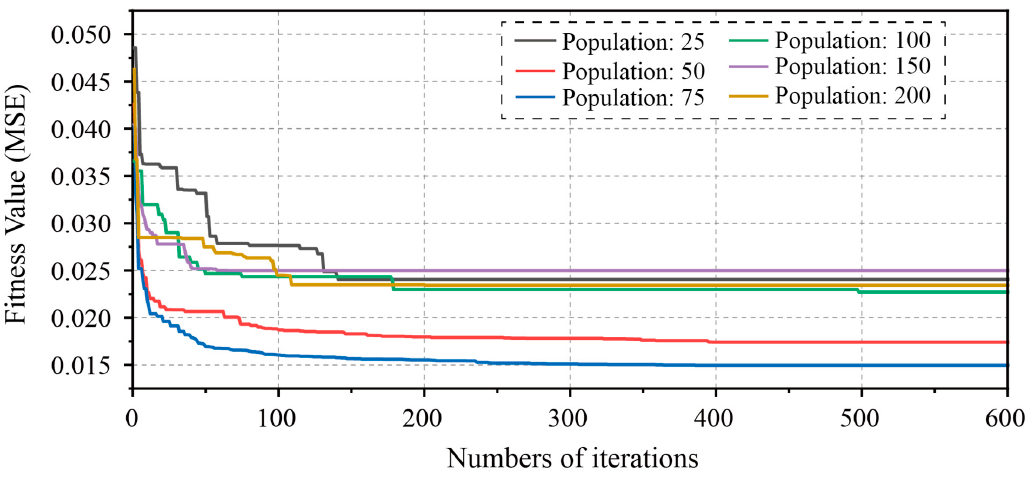
Figure 6. Training process of the KELM-GWO model.